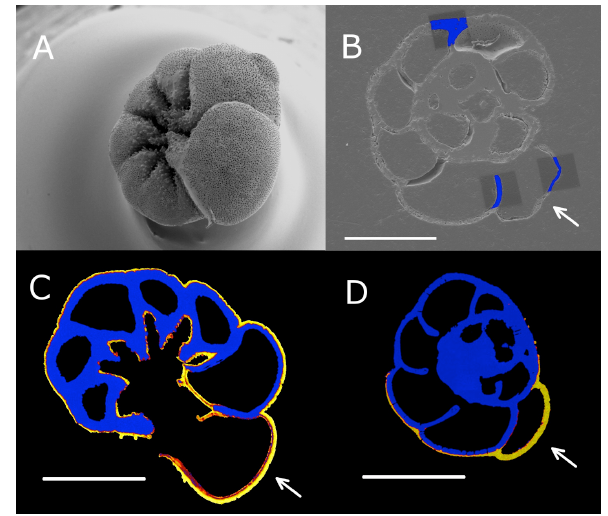
Figure 2: A) Scanning electron microscopy (SEM) image of an intact A. aomoriensis test. B) 260 Fig. 2. (A) Scanning electron microscopy (SEM) image of an in- SEM image of an embedded specimen (cross section) from Experiment 1, overlain with 261 tact A. aomoriensis test. (B) SEM image of an embedded speci- 44 Ca/ 40 Ca NanoSIMS maps. In these maps, blue areas signify normal 44 Ca/ 40 Ca ratio of 0.02 (c.f. 262 men (cross section) from Experiment 1, overlain with 44 Ca/ 40 Ca Fig S1). 44 Ca-label was added and removed prior to the onset of chamber formation. Absence of 263 NanoSIMS maps. In these maps, blue areas signify normal 44 Ca-enrichment in the test indicates absence of an internal Ca-pool. C and D) NanoSIMS maps 264 44 Ca/ 40 Ca ratio of 0.02 (cf. Fig. A1). A 44 Ca label was added and of two embedded specimens from Experiment 2 in cross section. The isotopic label was added at 265 removed prior to the onset of chamber formation. Absence of 44 Ca the onset of chamber formation. Blue color signifies a normal 44 Ca/ 40 Ca ratio of 0.02. Yellowish 266 enrichment in the test indicates absence of an internal Ca pool. (C) color indicates enhanced (by a factor of 5, c.f. Fig S1) 44 Ca/ 40 Ca ratio due to 44 Ca-enrichment of 267 and (D) NanoSIMS maps of two embedded specimens from Exper- the seawater. Newly formed chambers indicated by arrows. Scale bar is 100 µ m. 268 iment 2 in cross section. The isotopic label was added at the onset 269 of chamber formation. Blue color signifies a normal 44 Ca/ 40 Ca ra- tio of 0.02. Yellowish color indicates enhanced (by a factor of 5, cf. Fig. A1) 44 Ca/ 40 Ca ratio due to 44 Ca enrichment of the seawater. Newly formed chambers indicated by arrows. Scale bar is